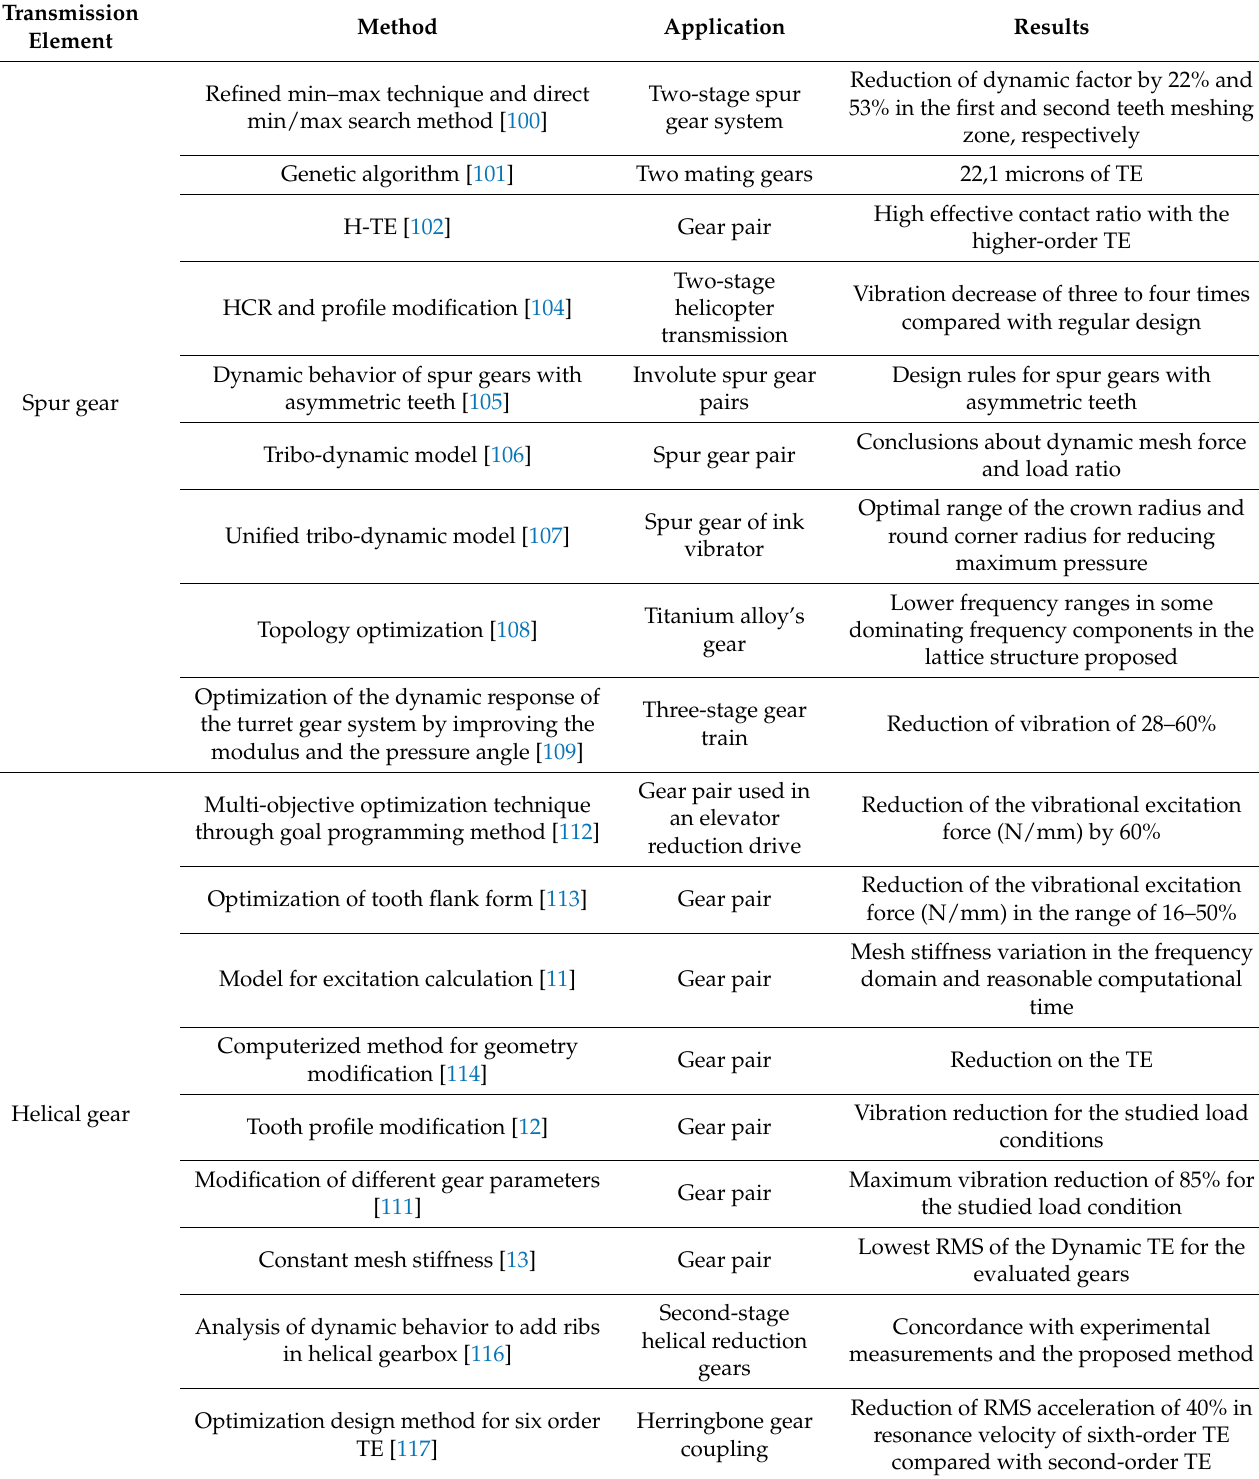
Table 2. Results of the design methods for reducing vibration in principal mechanical transmission elements.